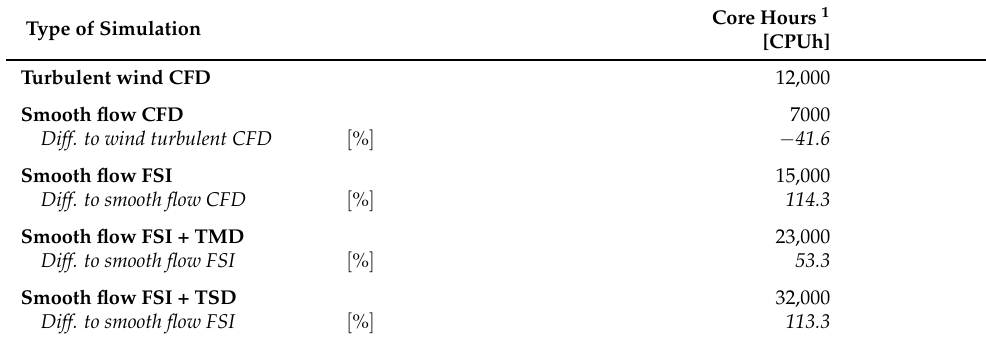
Table 6. Numerical effort required for